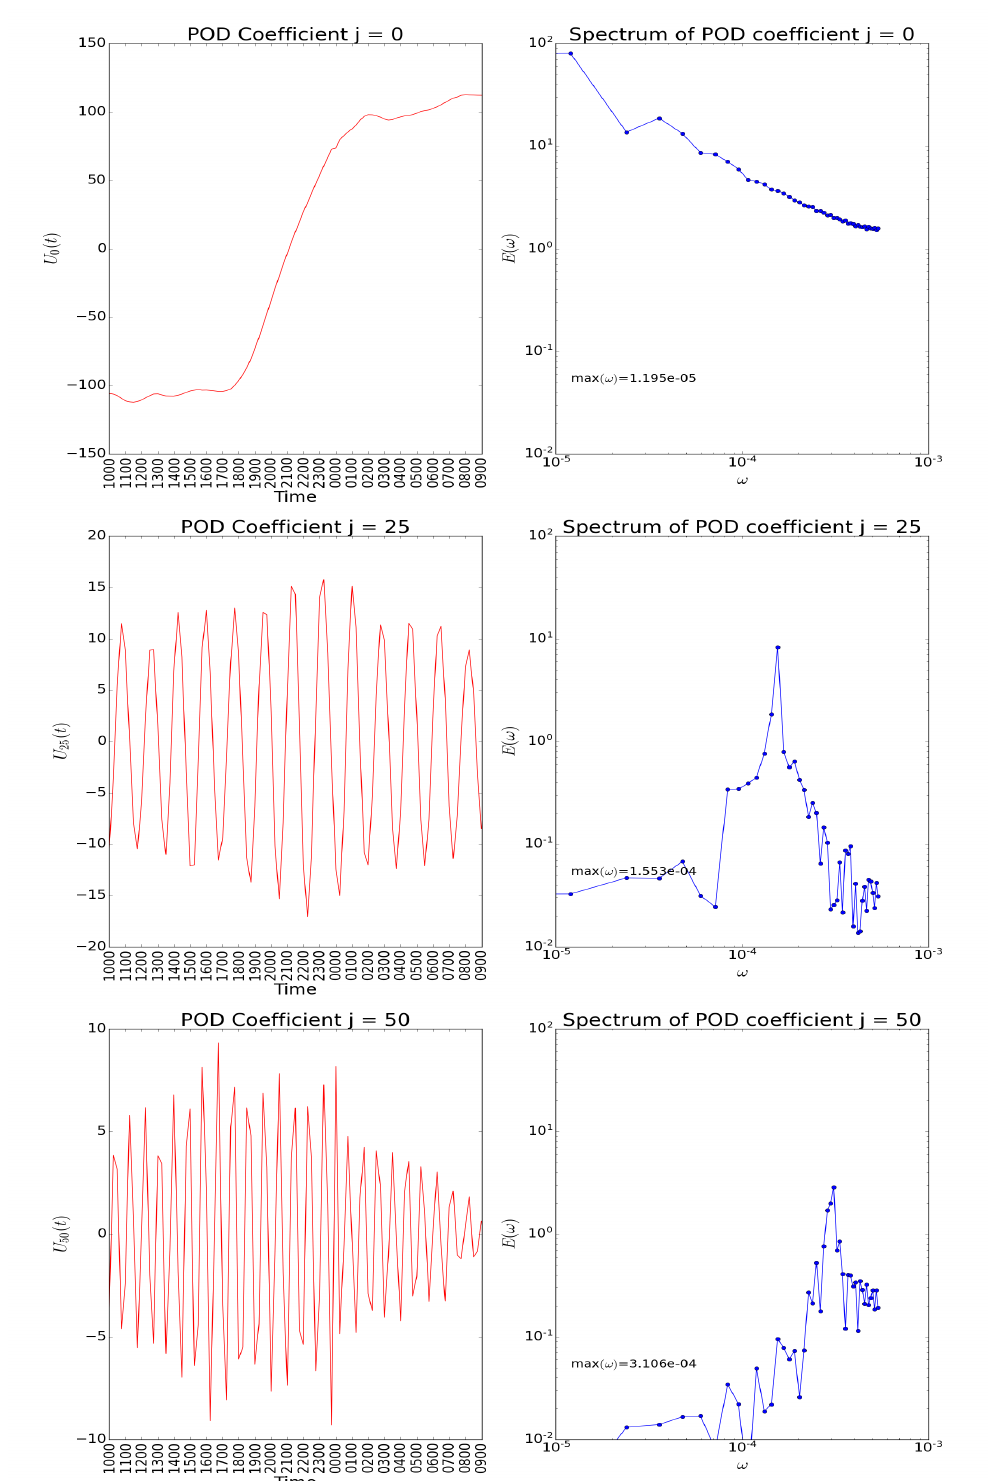
Figure 5. Left panels, from top to bottom: plot of the temporal evolution of the POD coefficients U 0 ( t ) , U 25 ( t ) , and U 50 ( t ) . Right panels, from top to bottom: Fourier spectra of the same coefficients for the Faraji